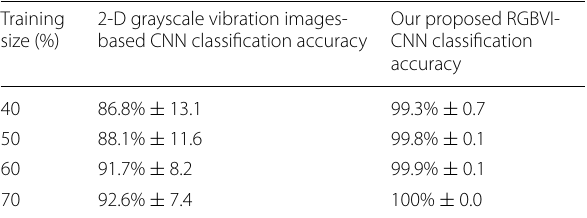
Table 4 Comparison with the results obtained using 2-D grayscale-based CNN Training size